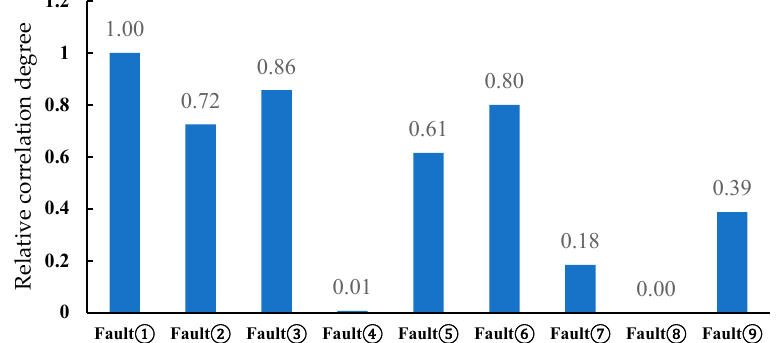
Figure 10. Relative correlation degree with each fault type.